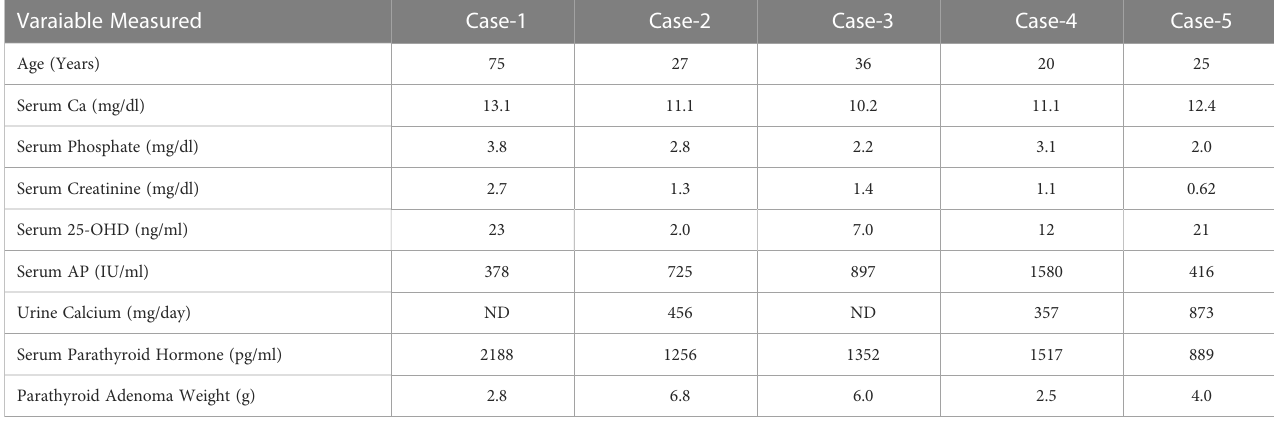
TABLE 1 Relevant biochemical and parathyroid adenoma weights in the 5 cases with Osteitis Fibrosa Cystica (OFC) from Detroit. Varaiable